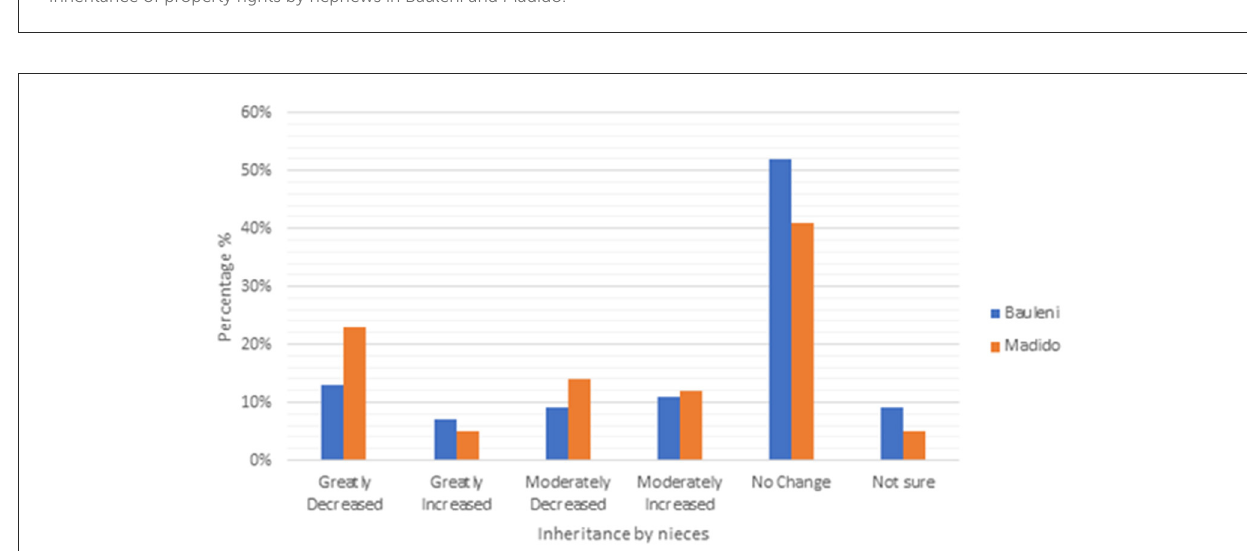
FIGURE8 Inheritance of property rights by nieces in Bauleni and Madido.